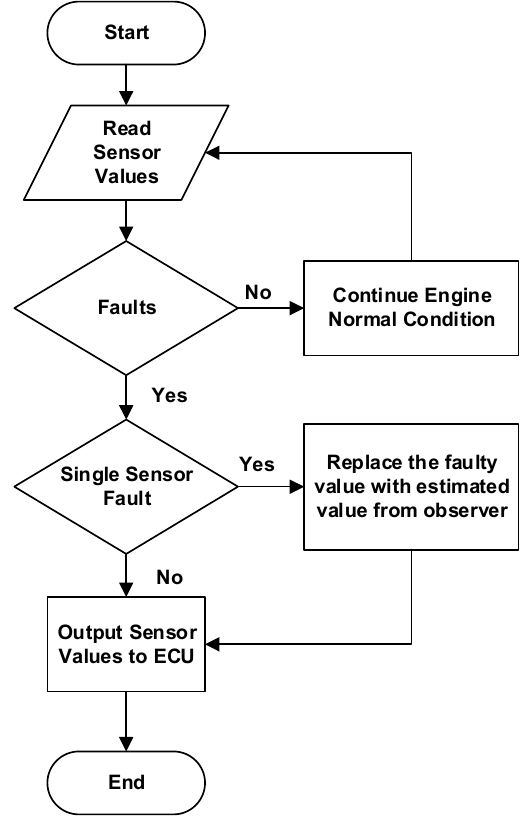
Figure 2. Flowchart of proposed AFTCS.